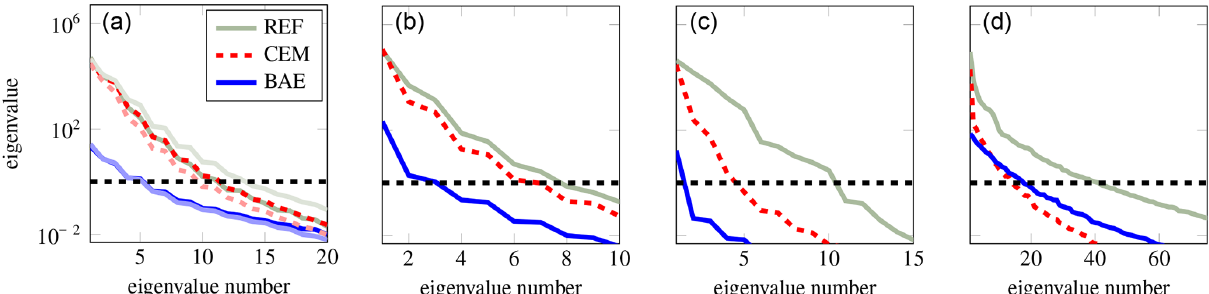
Figure 15. Spectra of the prior-preconditioned Hessian of the data misfit computed using Eq. (11) for Example 1 (a) , Example 2a (b) , Example 2b (c) , and Example 3 (d) . The spectra for Example 1a (coarse mesh) are shown in the fainter colors, while the spectra for Example 1b (fine mesh) are shown in the richer colors. The horizontal dashed black line (at λ = 1) shows the reference value for the truncation of the spectrum of the prior-preconditioned Hessian of the data